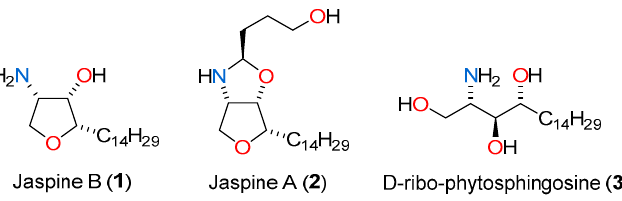
Figure 1. Structure of pachastrissamine (jaspine B) ( 1 ), jaspine A ( 2 ) a D-ribophytosphingosine ( 3 ). This natural sphingolipid 1 was independently isolated in 2002 and 2003 by T. Higa et al. and by the C. Debitus group from marine sponges, Pachastrissa sp. (family Calthro- pellidae) and Jaspis sp., respectively [1,2]. Due to its similar structure to other bioactive sphingolipids, jaspine B 1 has been also tested for its pharmacological properties and it has shown in vitro cytotoxic activity against several types of cancer cell (A-549, P-388,